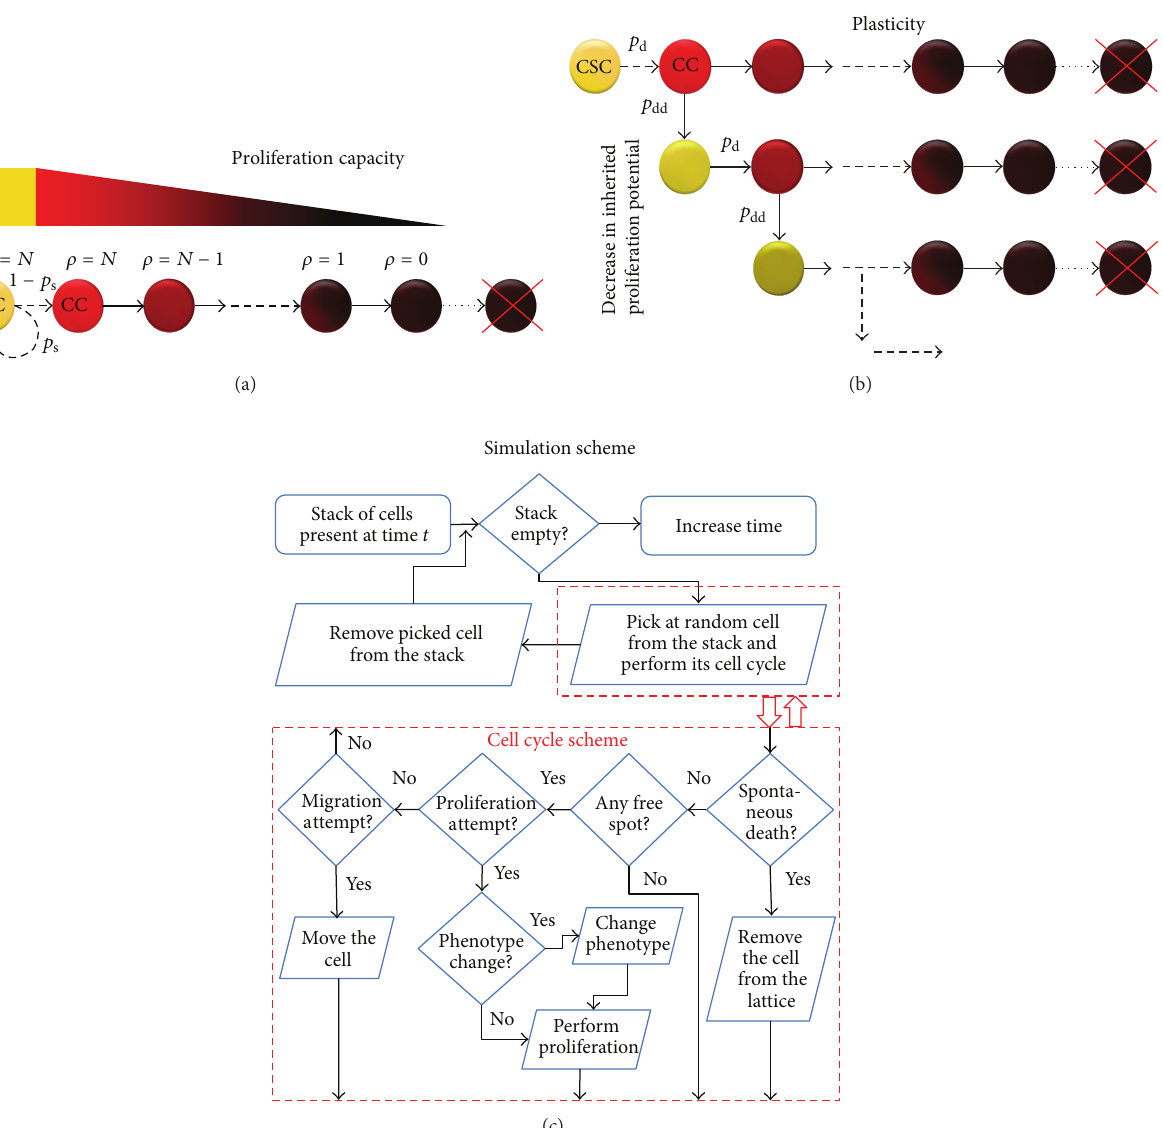
Figure 1: (a) Schematic of the proliferation potential erosion in the nonstem cancer cell (CC) population after asymmetric division of cancer stem cell (CSC) that occurs with probability 𝑝 s . (b) Schematic of cellular differentiation and dedifferentiation (probabilities 𝑝 d and 𝑝 dd , resp.), in which the proliferation potential is memorized in course of evolution. (c) Schematic of the simulation procedure and cell cycle evaluations.